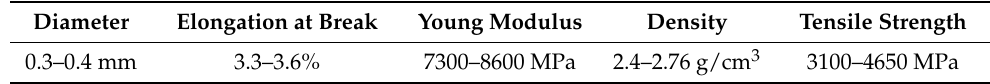
Table 1. The basic parameters of glass fiber.